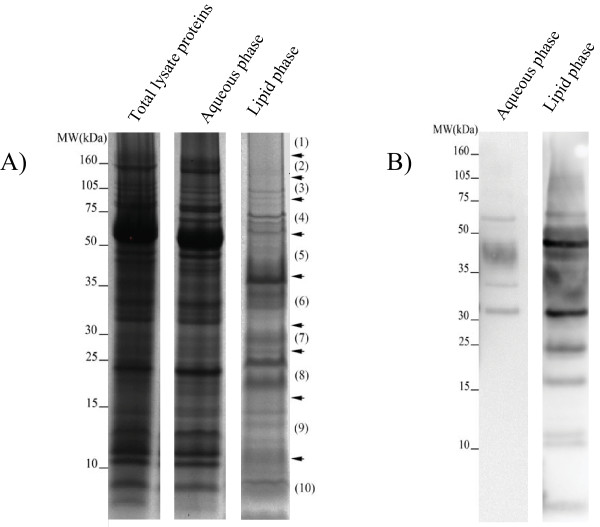
SDS-PAGE analysis of the extracted M. tuberculosis H37Rv proteins. Panel A, shows the whole cell lysate of M. tuberculosis H37Rv, the aqueous phase proteins and the lipid phase proteins after Triton X-114 extraction. The fractions for LC-MS/MS analysis of the lipid phase is indicated. Explanation of the fraction numbers: (1) >160 kDa, (2) 105-160 kDa, (3) 75-105 kDa, (4) 50-75 kDa, (5) 35-50 kDa, (6) 30-35 kDa, (7) 25-30 kDa, (8) 15-25 kDa, (9) 15-10 kDa, (10) <10 kDa. Panel B shows western blot analysis of the aqueous and lipid phases using a polyclonal rabbit antiserum against a BCG cell wall fraction. The molecular weight standards are shown on the left hand side of each panel.